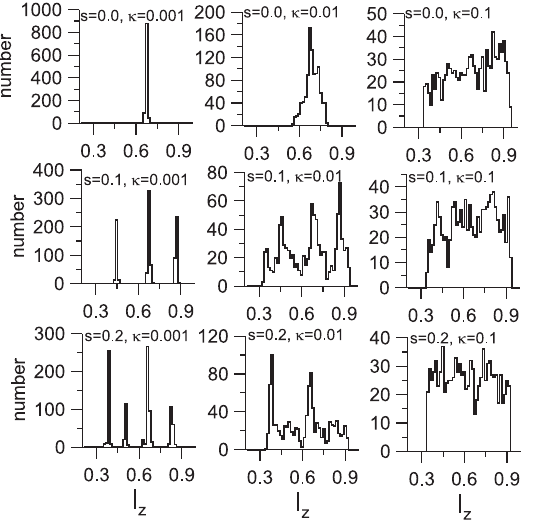
Fig. 9. Distributions of I z at various values of s and κ . Each distri- bution contains 10 3 values.